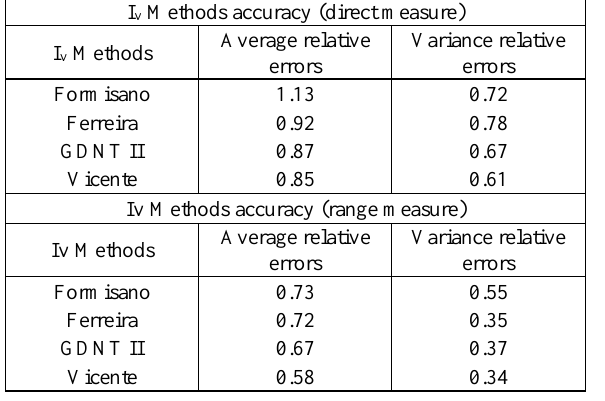
Table 6. Evaluation of the Iv method accuracy in the case study.